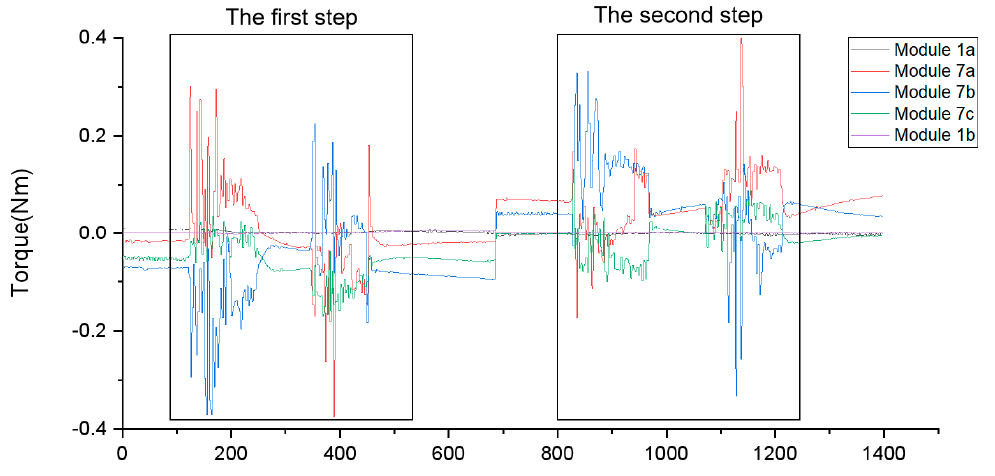
Figure 11. Motor torque waveforms of inchworm gait.